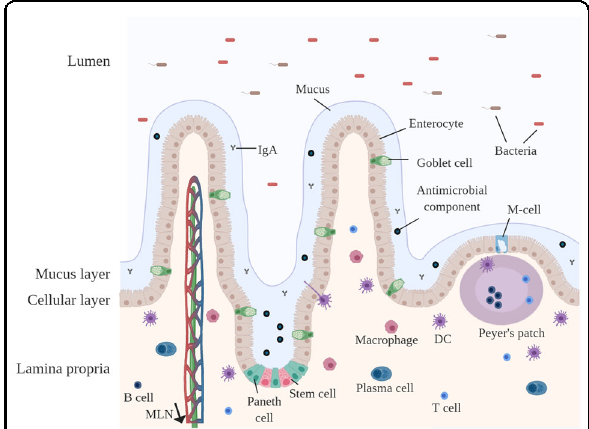
Fig. 3 The gastrointestinal immune barrier. The gastrointestinal immune barrier contains several layers that provide protection against harmful substances. From the outside (lumen) to the inside (lamina propria): (1) The mucus layer in the small intestine consists of a single loose layer, whereas in the colon, it consists of a loose outer layer and a dense inner layer. The mucus layer provides extra protection against pathogens due to the presence of IgA and antimicrobial peptides. (2) The cellular layer consists of a single layer of epithelial cells that forms a physical barrier against incoming antigens. (3) Beyond the cellular layer is the lamina propria, which is densely populated with immune cells. These immune cells provide protection against harmful substances but also induce tolerance against harmless